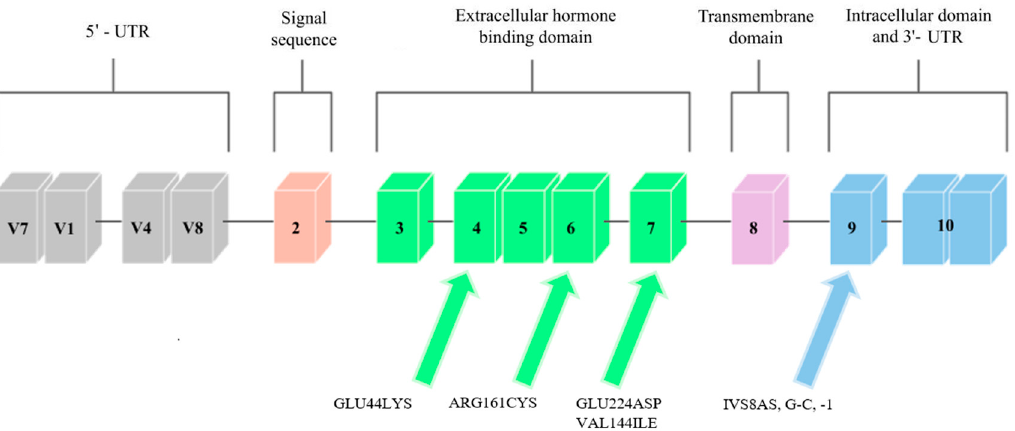
Figure 2. Scheme of the GHR gene. Arrows point to exons where mutations related to low body height or SGA/IUGR defined at birth have been found.